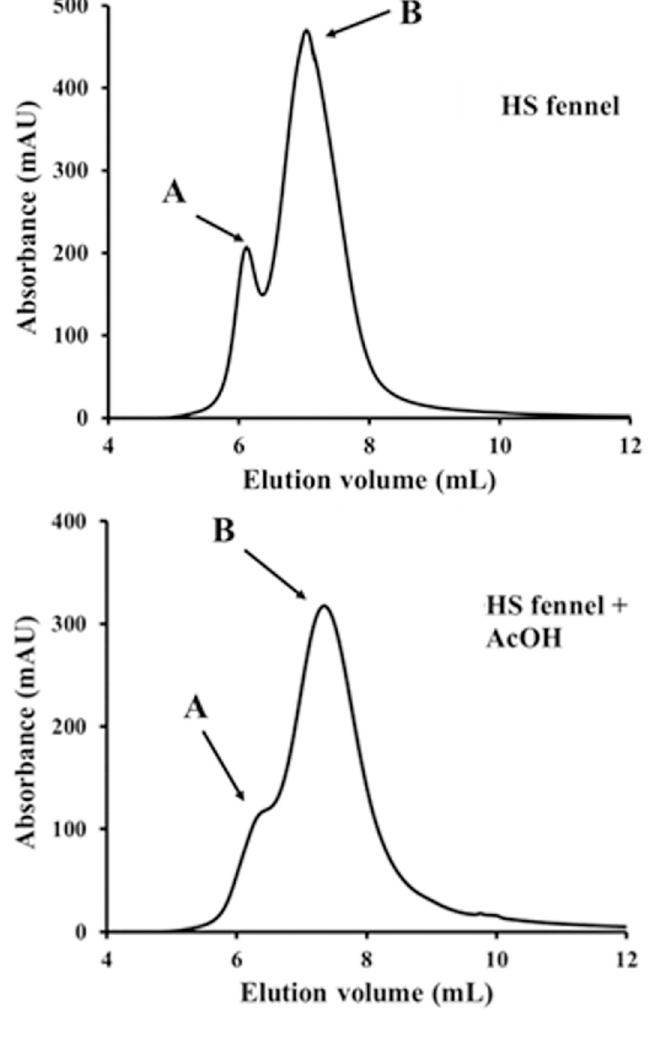
Fig 3. HPSEC chromatograms of HS-FEN before and after addition of acetic acid (AcOH) to lower solution pH from 7 to 3.5.